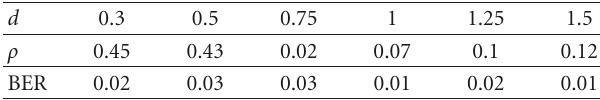
Table 1: Correlation value as a function of antenna